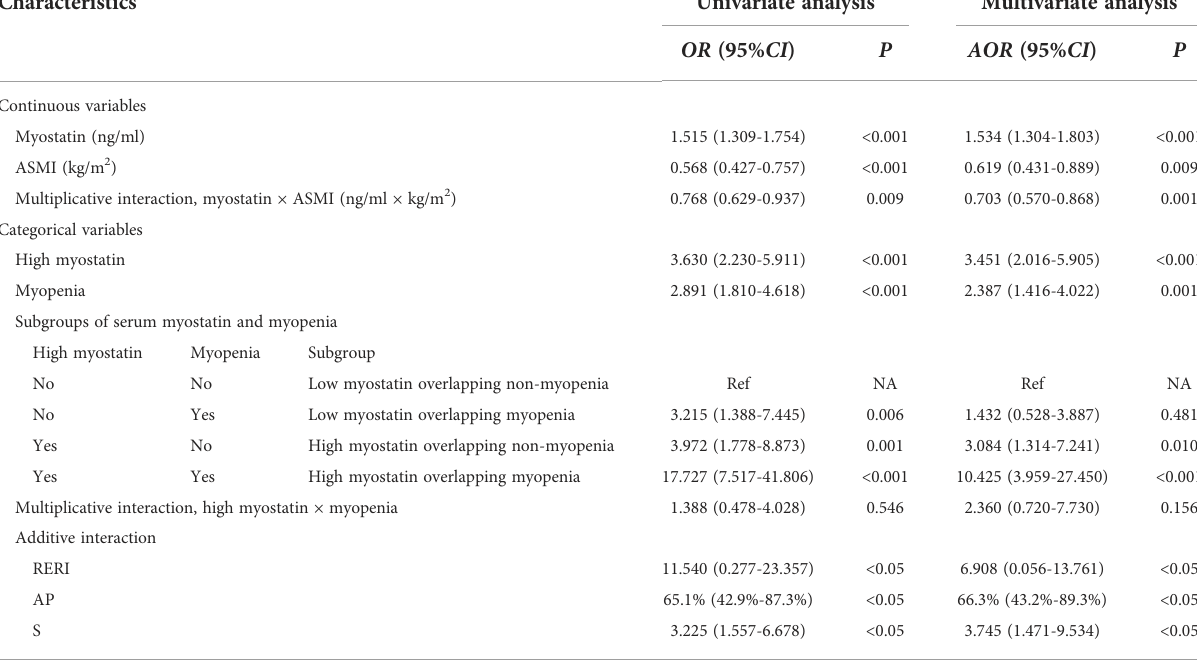
TABLE 4 Associations and interactions between baseline serum myostatin and myopenia with one-year radiographic progression in RA patients. Characteristics